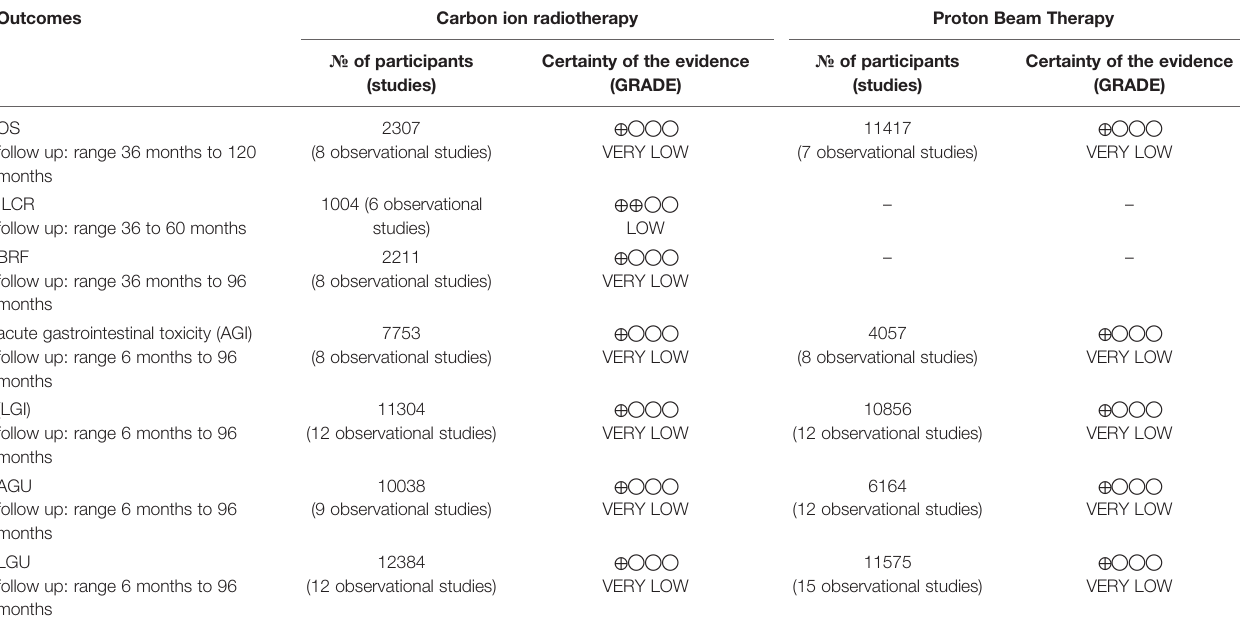
TABLE 2 | Summary of fi ndings of carbon ion radiotherapy and proton beam therapy for prostate cancer patients.